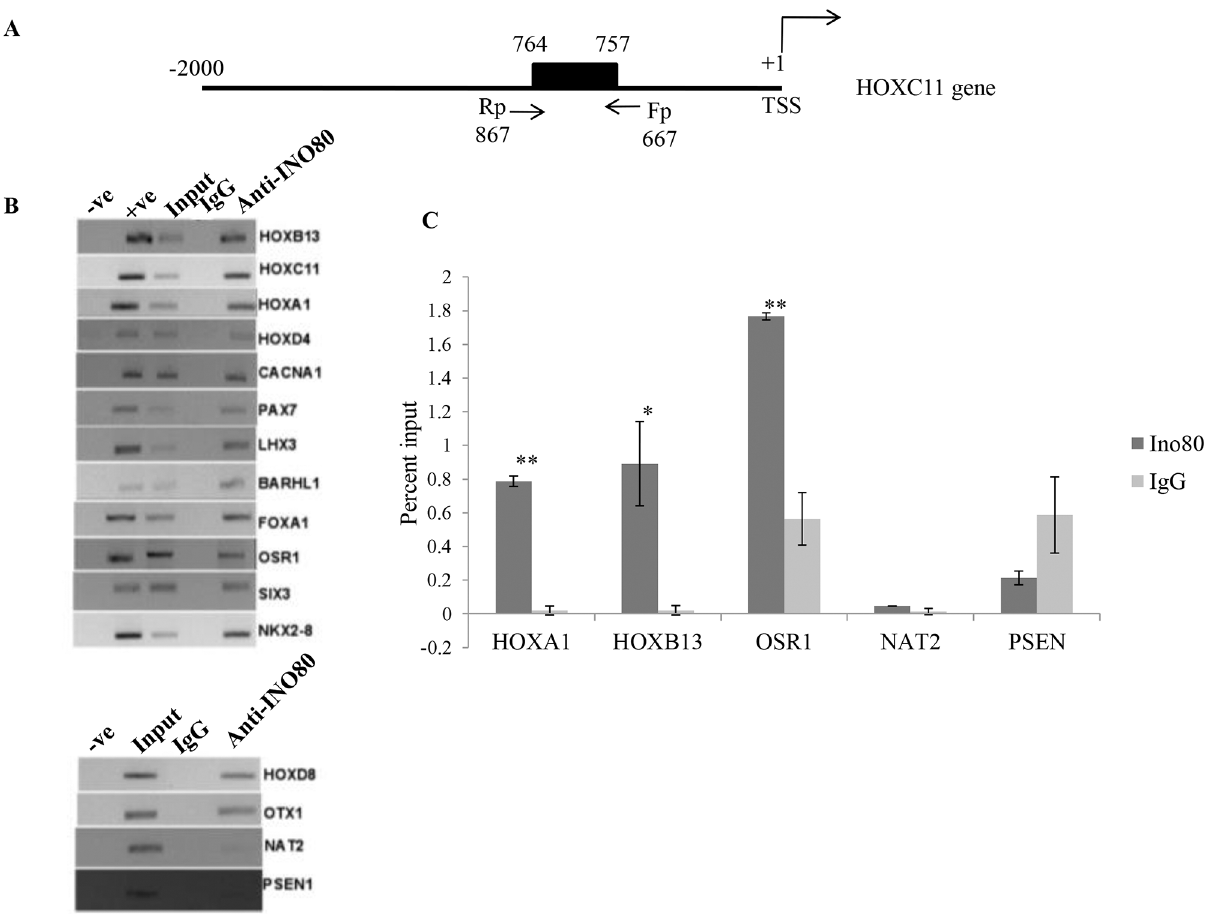
Fig 7. In vivo interaction of INO80 on predicted gene targets. (A) A line diagram for the region 2Kb upstream of HOXC11 gene is shown as the example of the region analyzed by ChIP. The filled rectangle denotes the INO80 binding motif and the position of the primers (arrows) are marked. (B) ChIP-PCR results for the indicated genes on the human genome. The interaction of INO80 protein was examined in the upstream sequences of these genes using INO80 antibody in HEK293T cells. IgG antibody was used as the negative control for ChIP experiment. The negative (-ve) and positive (+ve) indicate the PCR controls. Input is 20% of sonicated chromatin. (C) Quantitative PCR for putative INO80 targets following ChIP assay in HEK293T cells. The Y axis shows the enrichment as percentage input observed. NAT2 and PSEN lack the INO80 binding motif. ( * p value < 0.05, ** p value < 0.001 Two tailed Student